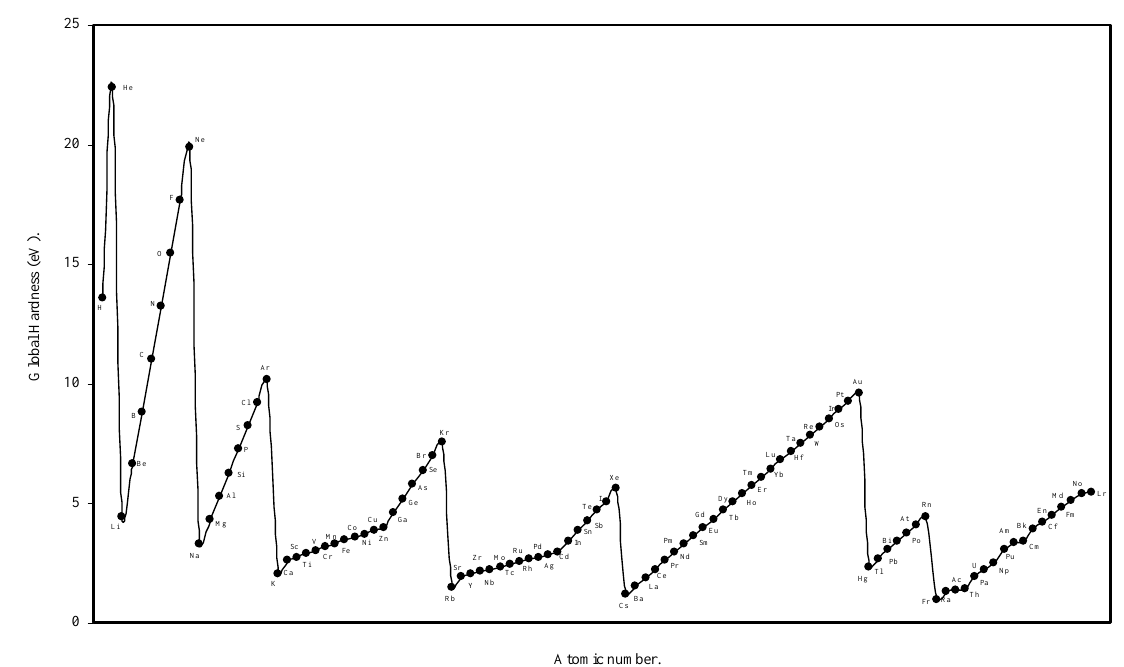
Figure 9. Plot of Global hardness (eV) of atoms as a function of atomic number.